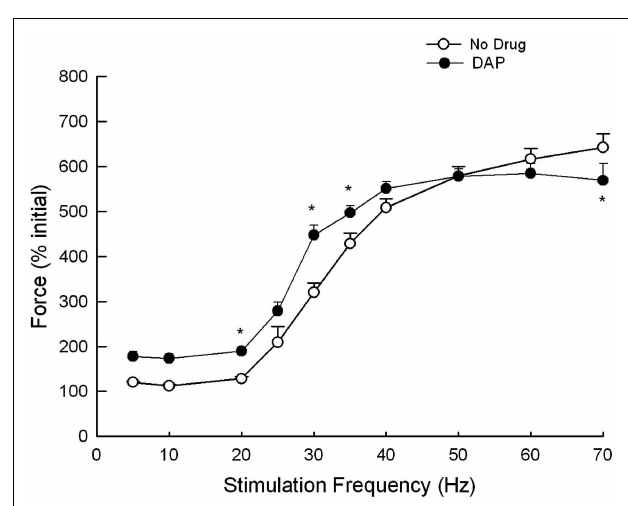
FIGURE 8 | Force during eccentric contractions of 1.2mm at constant velocity of 6mm/s at different frequencies with and without DAP. Data are expressed as a percent of the initial pre-drug isometric twitch force. Values are means ± SE.